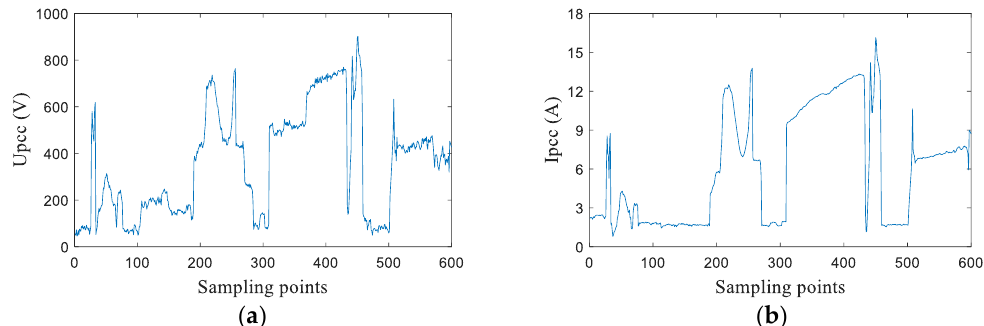
represented. Figure 16 shows the phase angles of the third harmonic voltage and current with load, expressed in the radian system. with load, expressed in the radian system. Figure 14. Schematic diagram of harmonic measurement. Figure 14. Schematic diagram of harmonic measurement.